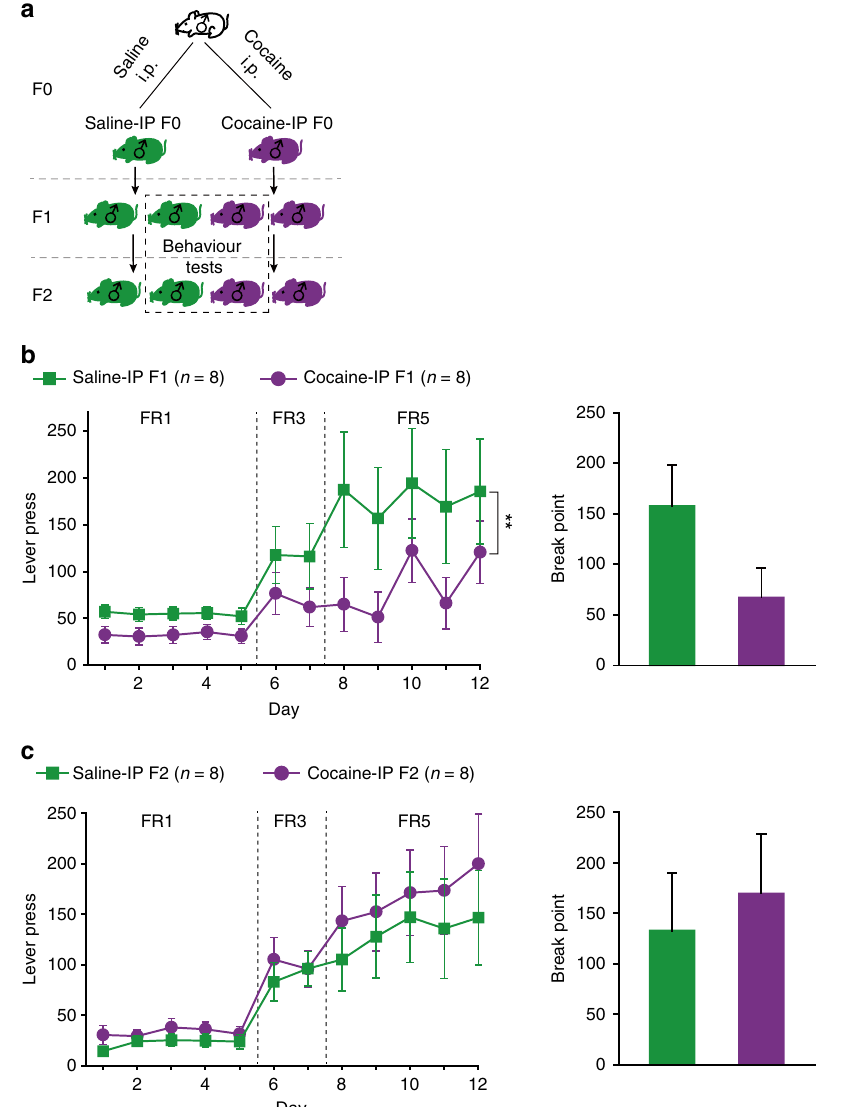
Figure 4 | Non-contingent chronic cocaine injections induce inter-generational cocaine resistance. ( a ) Rats received 15mgkg (cid:2) 1 cocaine (Cocaine-IP F0) or equal volume of saline (Saline-IP F0) intraperitoneal injections twice daily for 7 days and were mated with naive females one day after the last injection. Four litters from each of group were randomly designated for behavioural experiment or for mating to generate F2. ( b ) Cocaine-IP F1 did not show an increase but displayed a decrease tendency in lever press and break point for cocaine in self-administration test, compared with Saline-IP F1 rats. Lever press, Group (cid:3) FR, MMRM, w 2 (2) ¼ 13.00, P ¼ 0.0015; FR5, ** P ¼ 0.009, Saline-IP F1 versus Cocaine-IP F1. Break point, Mann–Whitney Rank-Sum Test, Z ¼ 1.060, P ¼ 0.289. Saline-IP F1, n ¼ 8; Cocaine-IP F1, n ¼ 8. ( c ) There was no statistical difference in lever press or break point between Saline-IP F2 and Cocaine-IP F2. Lever press, Group (cid:3) FR, MMRM, w 2 (2) ¼ 2.60, P ¼ 0.272. Break point, Mann–Whitney Rank-Sum Test, Z ¼ 0.638, P ¼ 0.526. Saline-IP